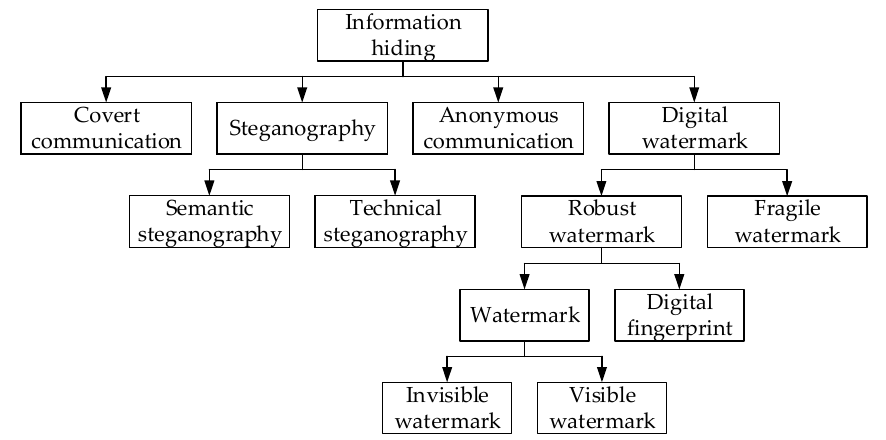
Figure 1. Main branches of information hiding.